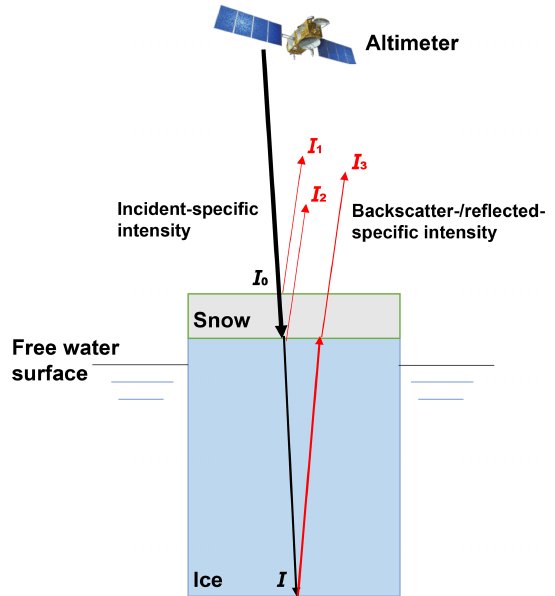
Figure 5. A schematic diagram of radar-altimetry-specific intensity backscattered/reflected from ice-covered lakes. Black arrows denote the incident-specific intensity. Red arrows denote backscattered- or reflected-specific intensity. I 0 denotes the transmitted microwave intensity just below the snow–ice interface. I denotes the transmit- ted microwave intensity that has just reached the ice–water inter- face. I 1 denotes the backscattered intensity from the air–snow inter- face, I 2 denotes the backscattered intensity from the snow–ice inter- face, and I 3 denotes the backscattered intensity from the ice–water interface. Note that, at the nadir, the incident angle is small, and the backscattered/reflected pulse is approximately collinear with the in- cident radar